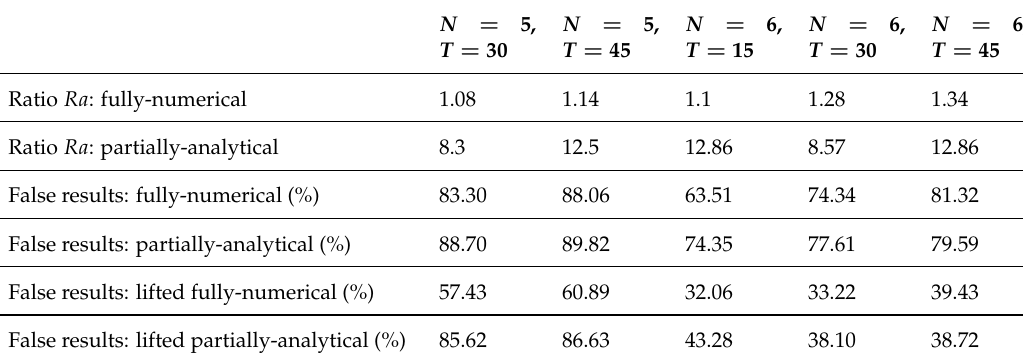
Table 9. The self-calibration results are based on a 2D model of synthetic LPM measurements where the offset is eliminated by subtracting one measurement equation from all others. The identified false optimizations have an error larger than 0.1.